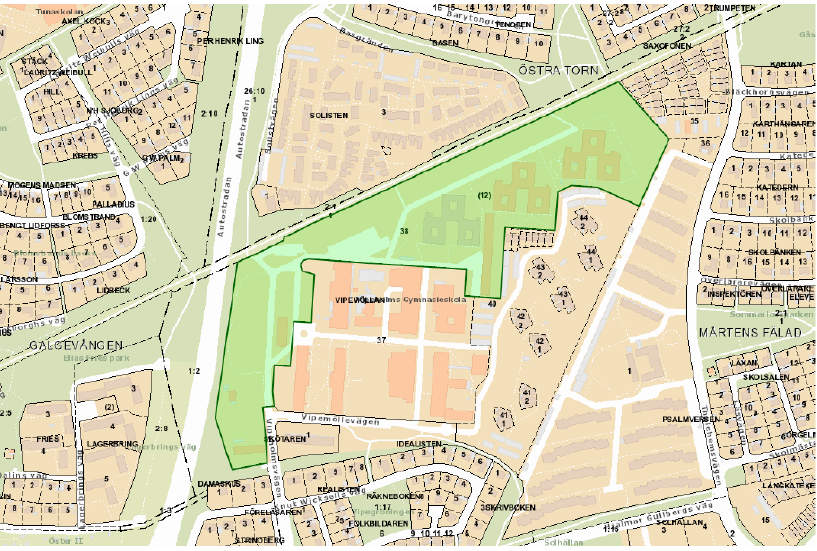
Figure 3. The Vipeholm area where housing development commenced in 2015. Source: [42].